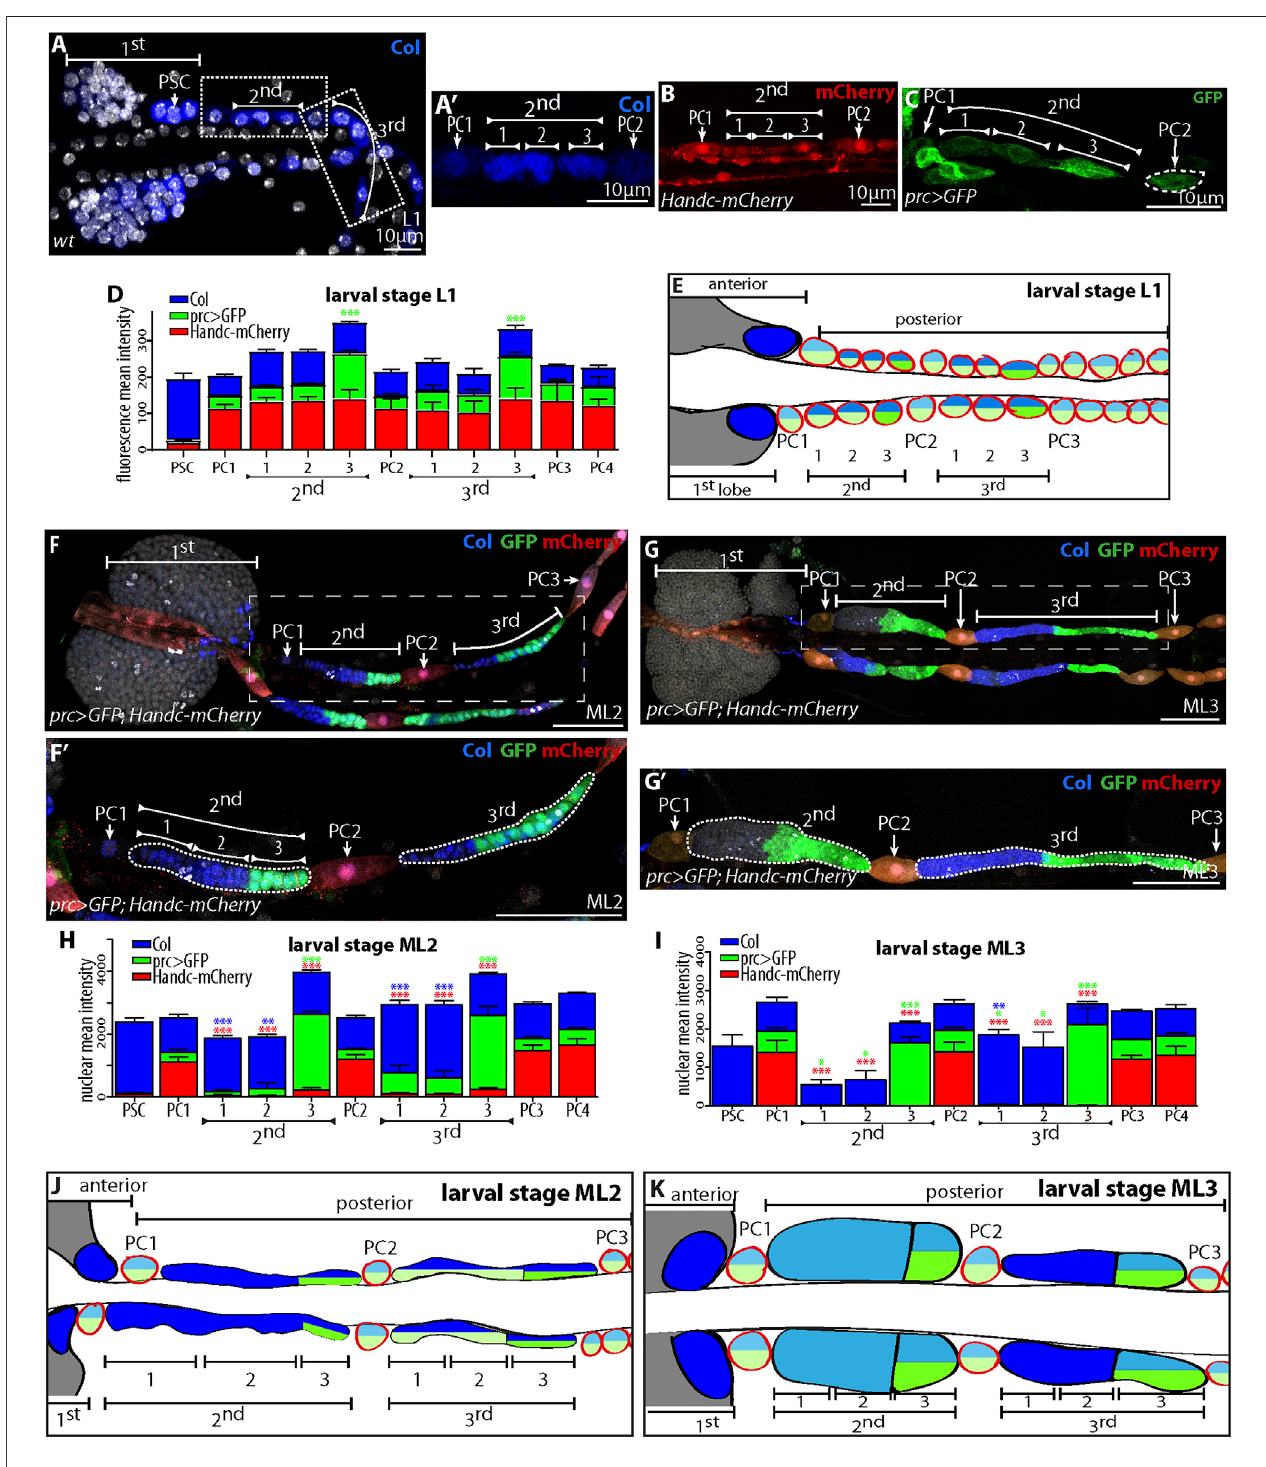
FIGURE 3 | Heterogeneity in posterior lobe cells established during larval development (A – C) Lymph gland of fi rst instar larvae (L1). (A,A ’ ) Col (blue) expressed in the PSC and in progenitors of the fi rst lobe, as well as in all PCs, Dapi (white) labels nuclei. (A ’ ) Enlarged views where PC1 and PC2 are indicated, as well as the three bipotent nephrocyte/blood cells giving rise to the second lobe. Col (blue) isexpressed in both PCs and bipotentnephrocyte/blood cells. (B) Handc-mCherry (red) labels cardiac and pericardial cells. (C) prc > GFP (green) labels pericardial cells. GFP is expressed at higher levels in third bi-potent nephrocyte/blood cells. (D) Quanti fi cation of Col, prc > GFP and Handc-mCherry. (E) Schematic representation of lymph gland posterior lobes in L1 larvae. Col is blue, or dark blue for higher expression levels, prc > GFP is green, and Handc-mCherry is represented by red circles. (F,F ’ ,G,G ’ ) prc > GFP (green) lymph gland of mid second instar larvae